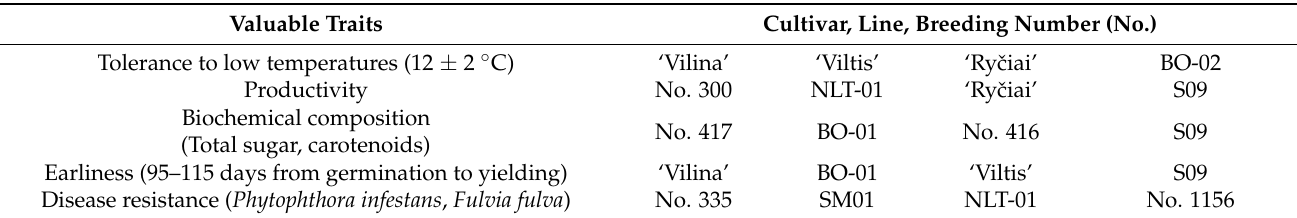
Table 1. Parental material from tomato national and adapted genetic